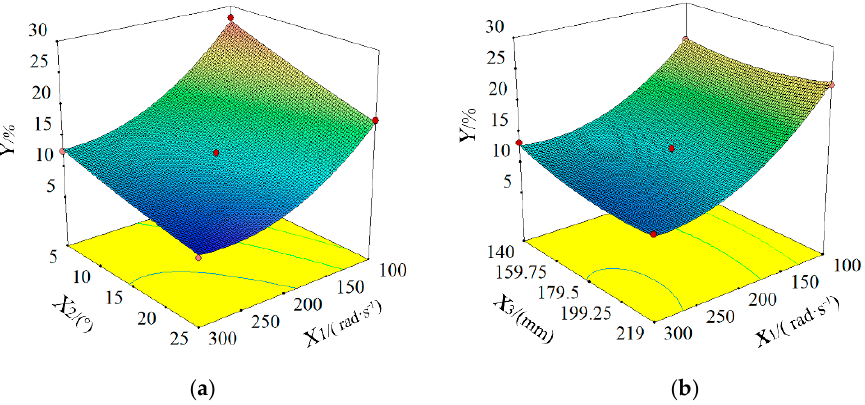
Figure 15. The influence of the inclination angle of the blade and the rotating speed of the vane-type film removal roller on the area ratio ( a ) and the influence of the diameter of the roller and the rotating speed of the vane-type film removal roller on the area ratio ( b ).